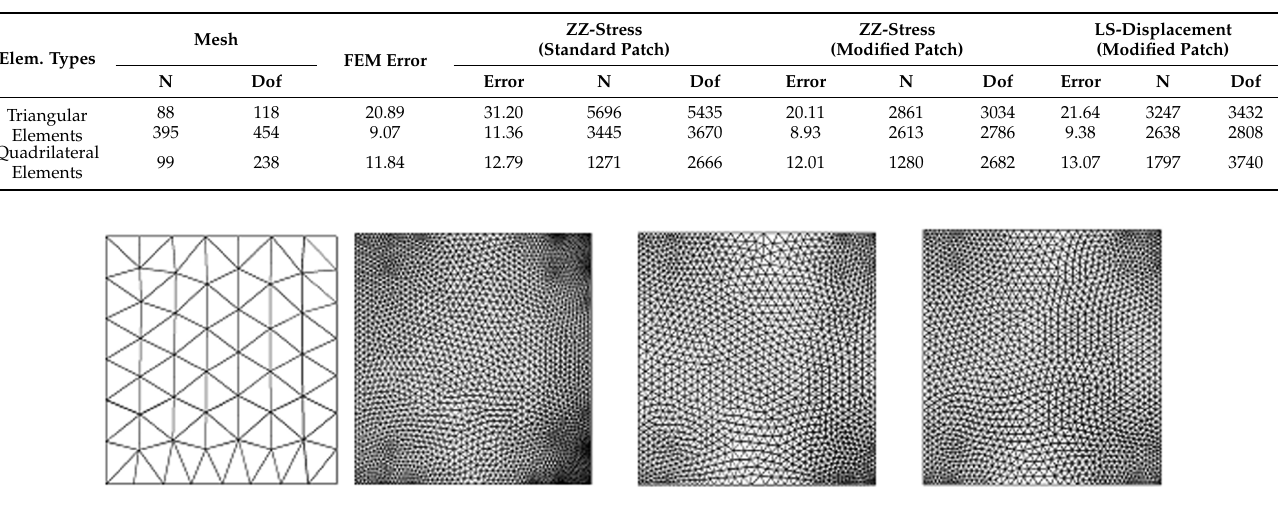
Table 10. Global errors (FEM and projected) and number of element (N) with DOF of adaptively refined meshes in a plate problem using stress/displacement recovery and patch configuration (4% target error).